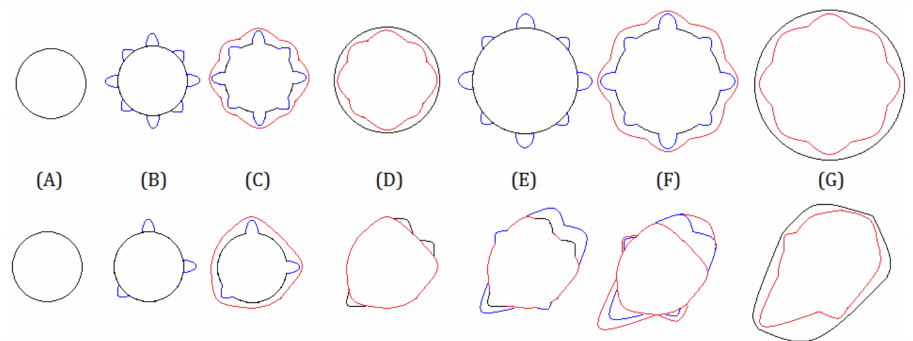
Figure 10. Schematic description of the kinetically limited growth mechanism undergone by BICUTIVOX ( upper row ) as compared to BICUVOX ( bottom row ). Different colors are used to indicate sequential layers of